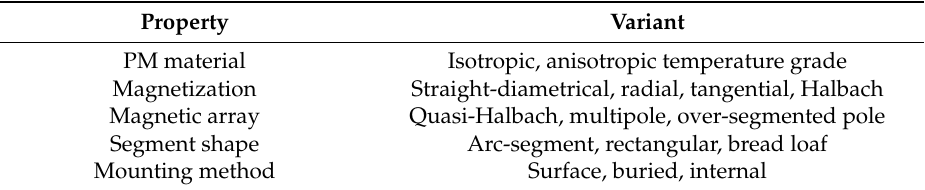
Table 2. Overview of evaluated topological choices.